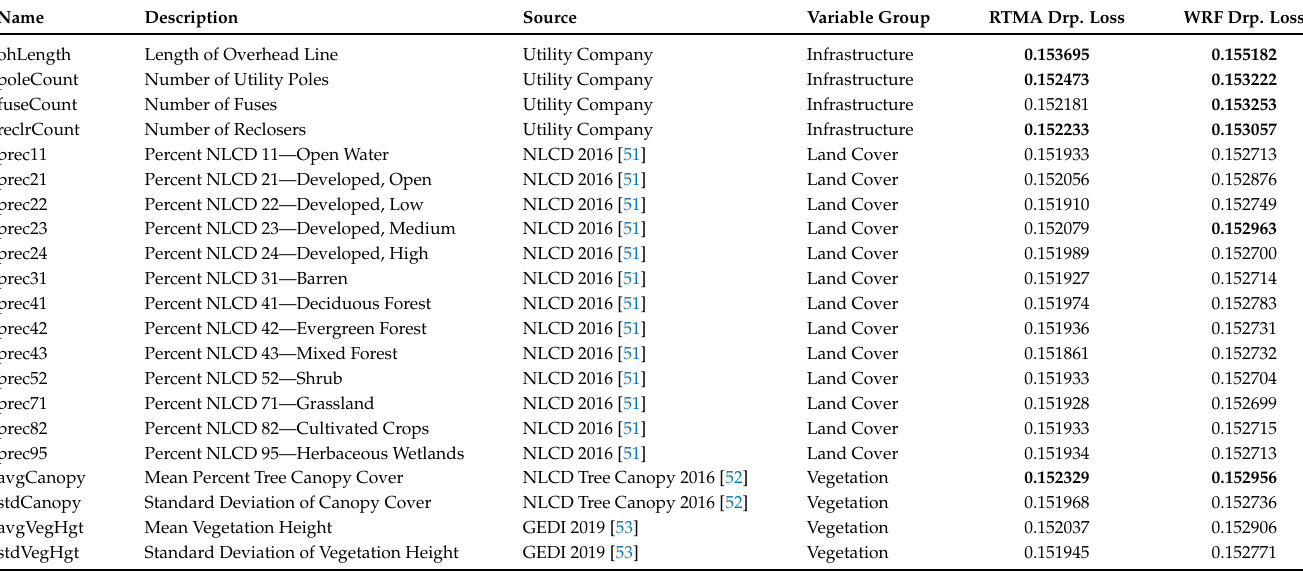
Table A1. Description of variables used in outage prediction models. The dropout loss of the top ten variables for each model are in bold. Higher dropout loss indicates greater